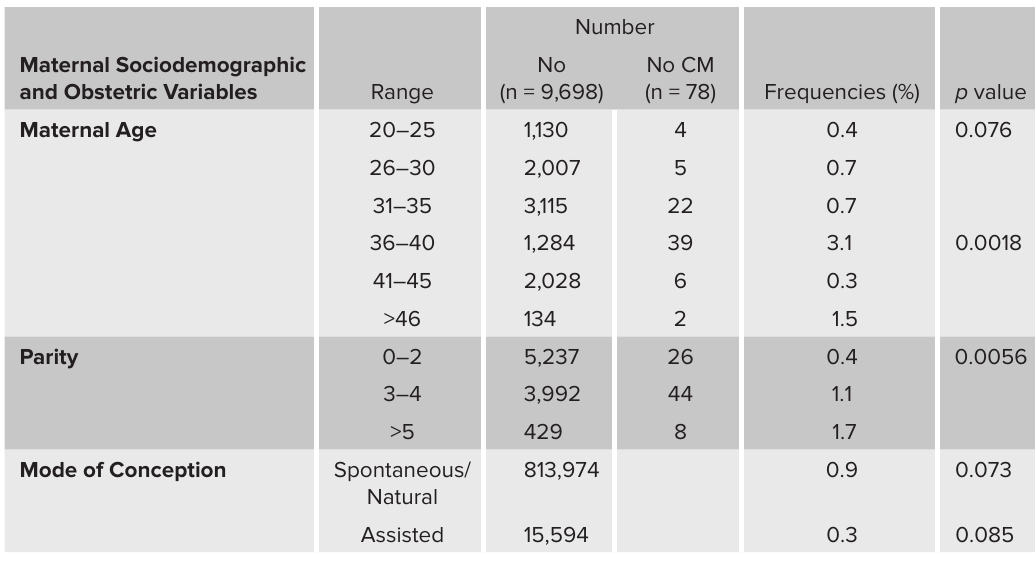
Table 3 : Relationship of Major Congenital Malformations with Maternal Sociodemographic and Obstetric